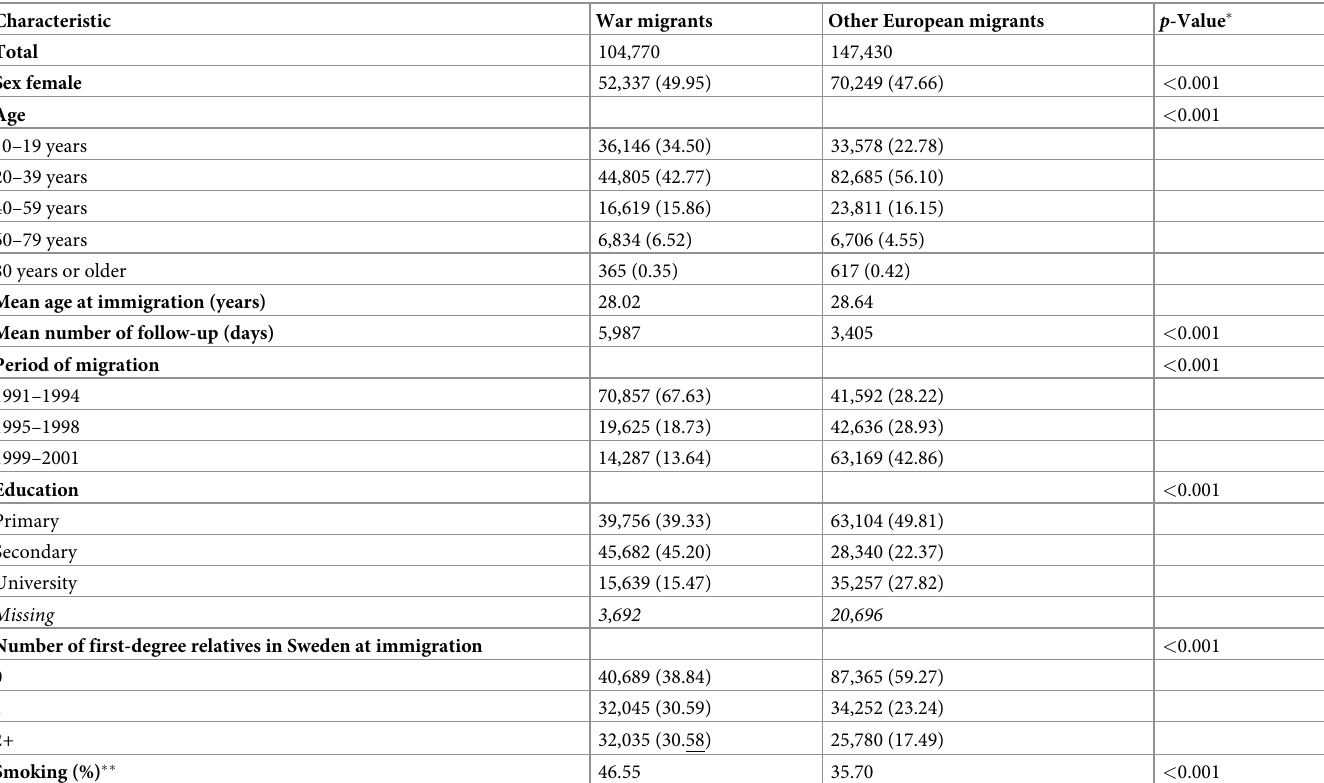
Table 1. Descriptive characteristics of migrants of the Balkan wars and other European migrants to Sweden during